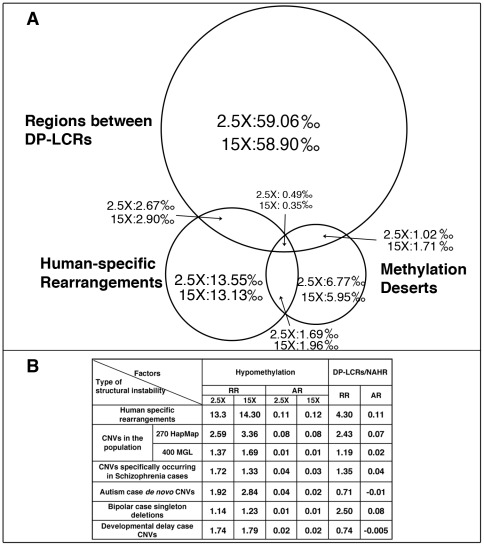
Statistical risk analysis of structural mutability due to hypomethylation and DP–LCRs.(A) Venn diagram of 100 Kbp windows classified into one or more of the following three categories: (i) windows containing human-specific structural rearrangements; (ii) windows within methylation deserts (windows with lowest 1% methylation at 2.5× or 15× coverage); and (iii) windows containing regions between DP-LCRs. Numbers within the circle areas indicate fraction (per mil) of the genome occupied by the specific groups of windows. (B) Statistical relative risk (RR) and statistical attributable risk (AR) of structural instability for hypomethylation and DP-LCRs (the first row corresponds to A).